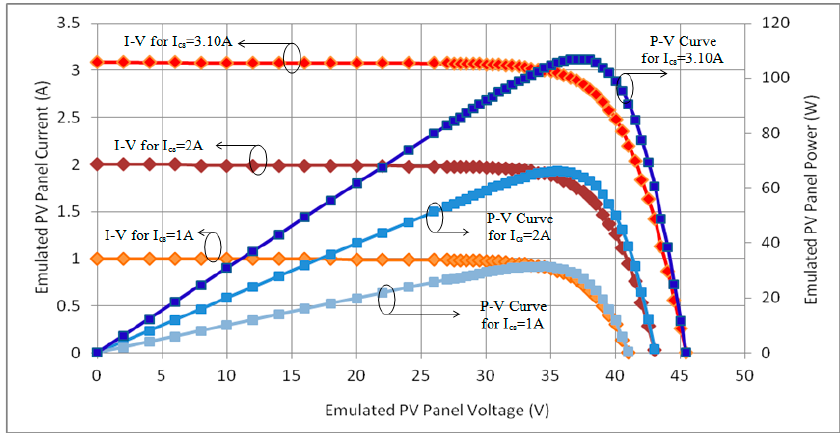
Figure 14. Measured electrical characteristics of the constructed PV source based on single solar panel at different excitement currents.